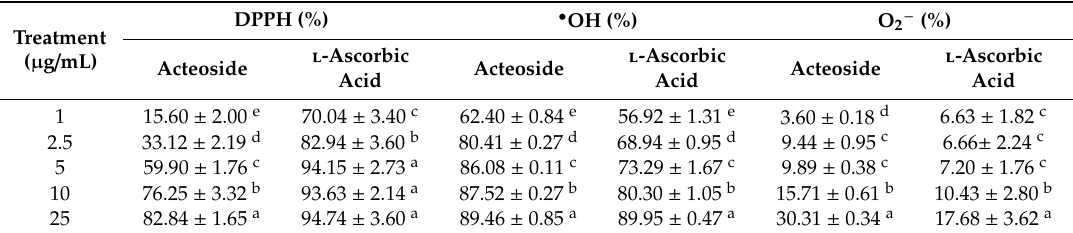
Table 2. DPPH, • OH, and O 2 − radical scavenging activities of A. distichum -derived acteoside.